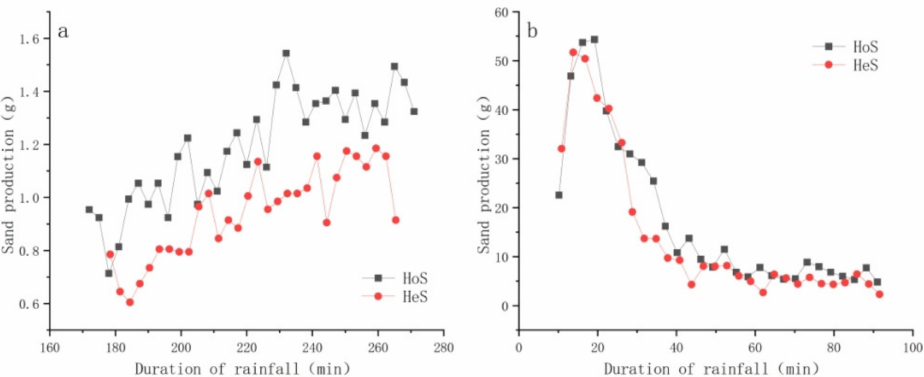
Figure 4. Surface sediment production process under different rain patterns ( a ) Long duration-low intensity rain; ( b ) Short duration-high intensity rain. HoS, Homogeneous soil. HeS, Heterogeneous soil. HeS + SM, Heterogeneous soil + Straw